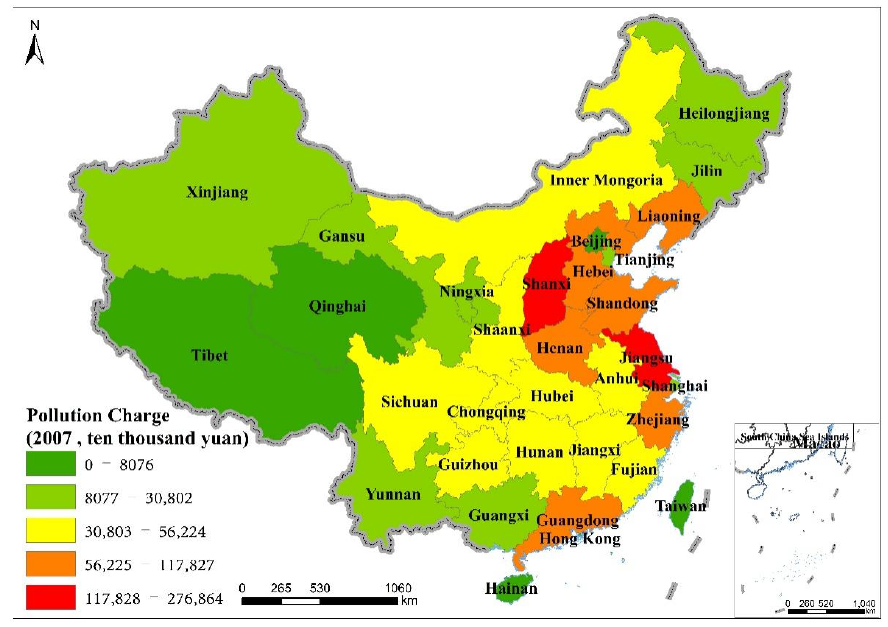
Figure 2. China’s pollution charges in 2002.